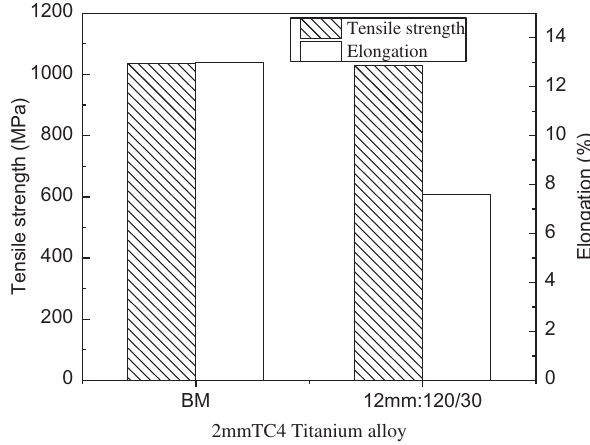
Figure 7: Tensile properties of 2mm thick joints without surface indentation at 120